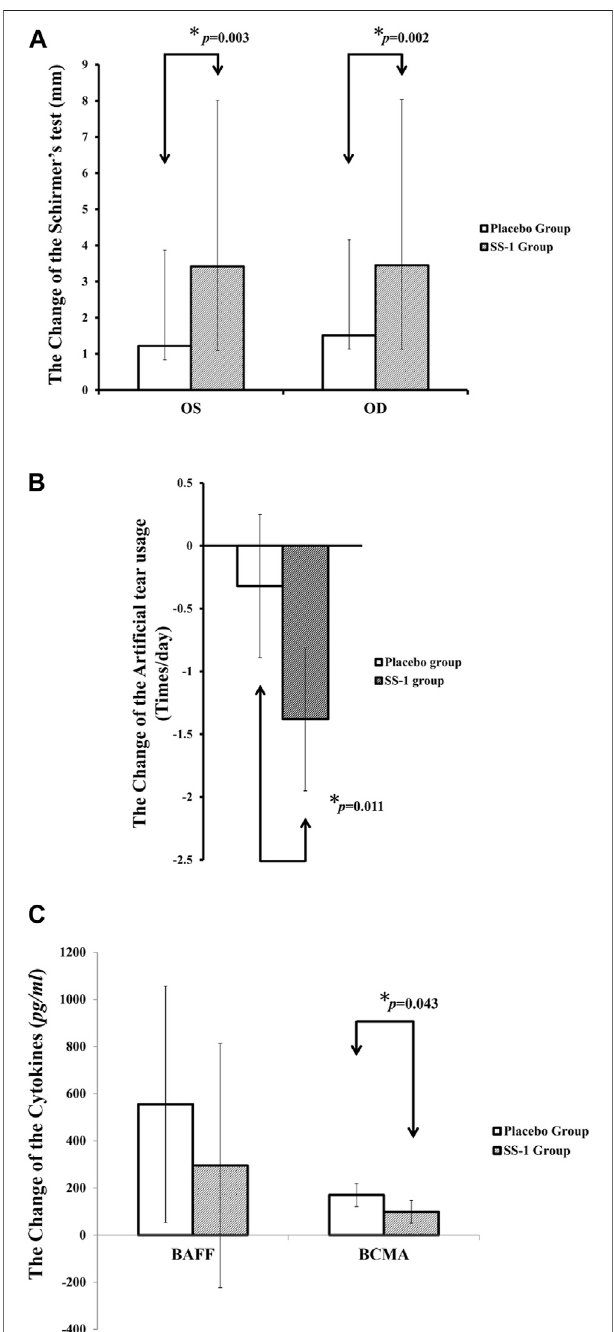
FIGURE 4 | The outcome improvements in (A) Schirmer ’ s test, (B) Arti fi cial tear usage after the integrated treatment, and (C) serum levels of BAFF and BCMA after the integrated